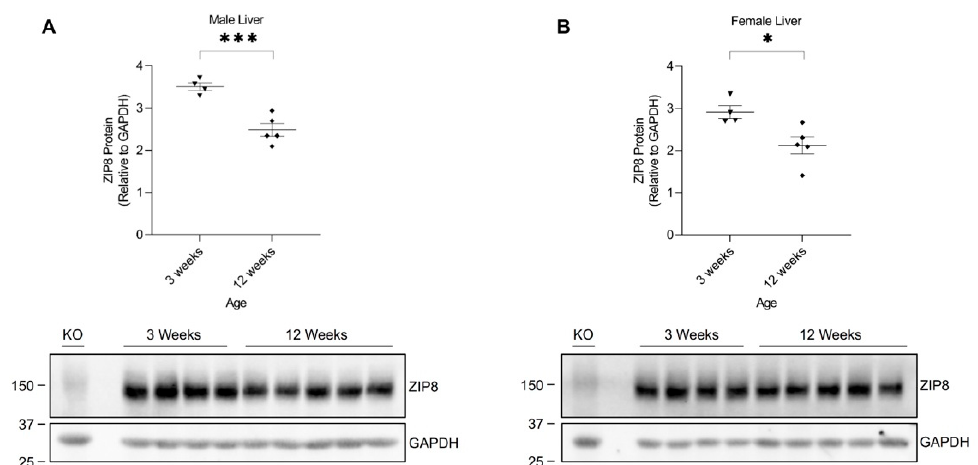
Figure 7. Comparison of liver ZIP8 protein levels between 3-week-old and 12-week-old mice. Ex- pressions of ZIP8 in male ( A ) and female ( B ) mice at 3 weeks and 12 weeks of age were analyzed by Western blotting ( n = 4–5/group). Samples with equal amounts of protein (200 µ g) were assessed. Blots include the liver sample from a female, 6-week-old Zip8 -KO mouse (fed a traditional rodent diet) as a control. Quantification of ZIP8 levels were determined using GAPDH as the loading control. Data are expressed as mean ± SEM. * p < 0.05, *** p < 0.001.